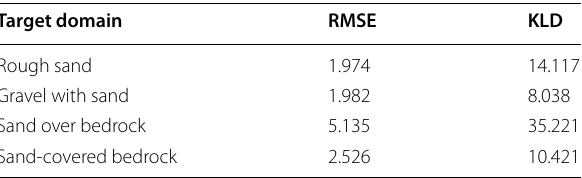
Table 6 Domain similarity (cid:31) i and weight w i learned for each source domain for the power consumption modeling